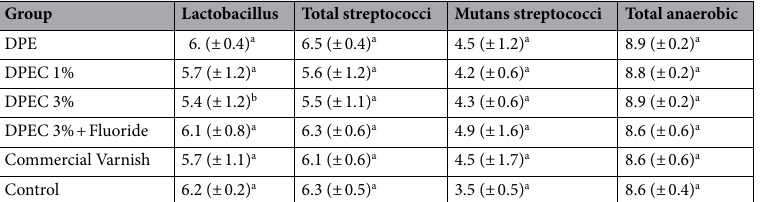
Table 4. Bacterial viability (log CFU mg −1 ) for biofilm microcosms. Similar letter indicates no statistically significant differences in CFU counts between the groups tested. A value of p ≤ 0.05 was considered significant (Tukey’s test).